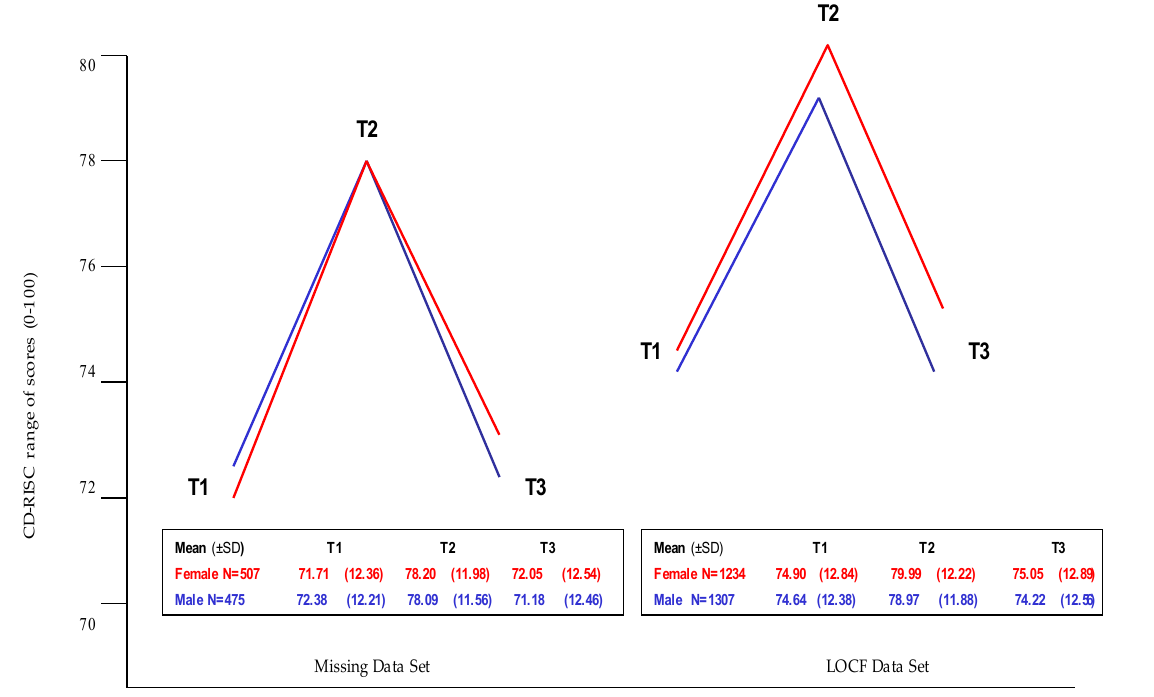
Figure 2 Pre (T1), post (T2) and follow-up (T3) mean CD-RISC Total Resilience by gender